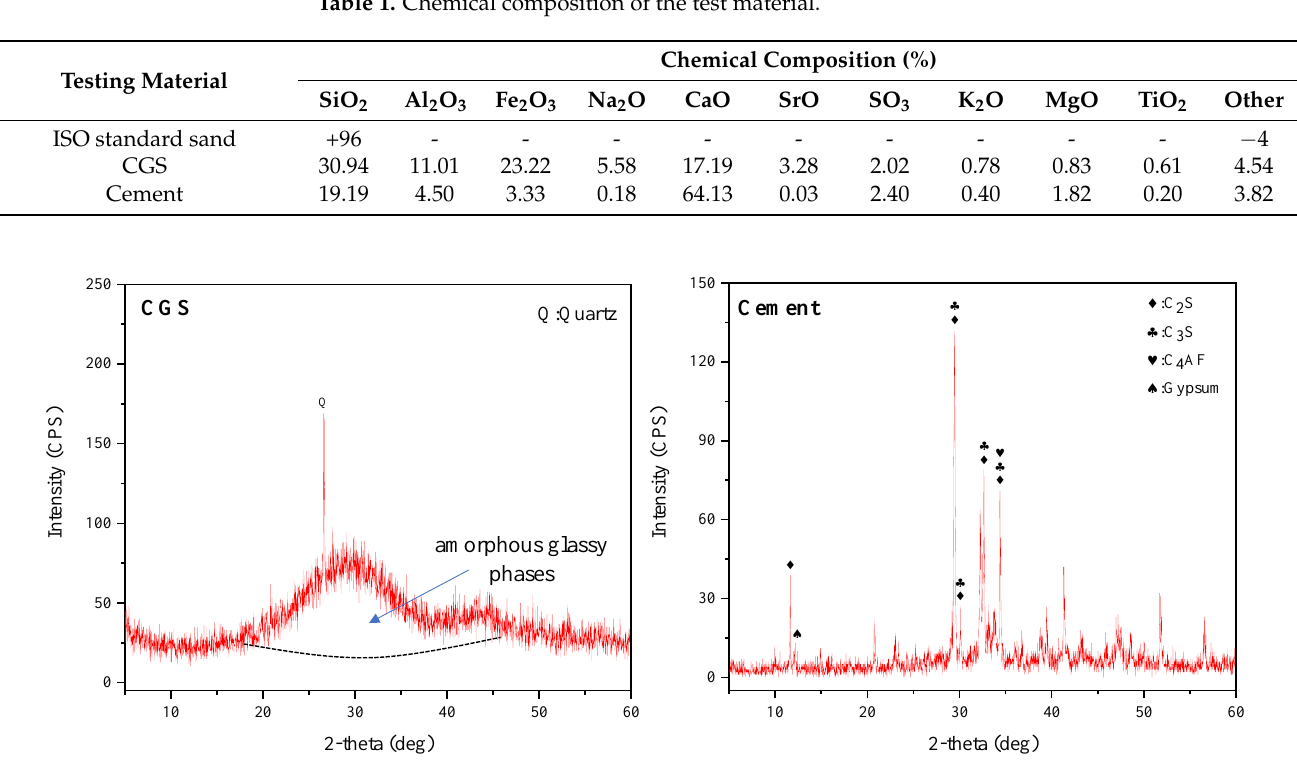
Figure 1. Mineral composition of CGS powder and cement.